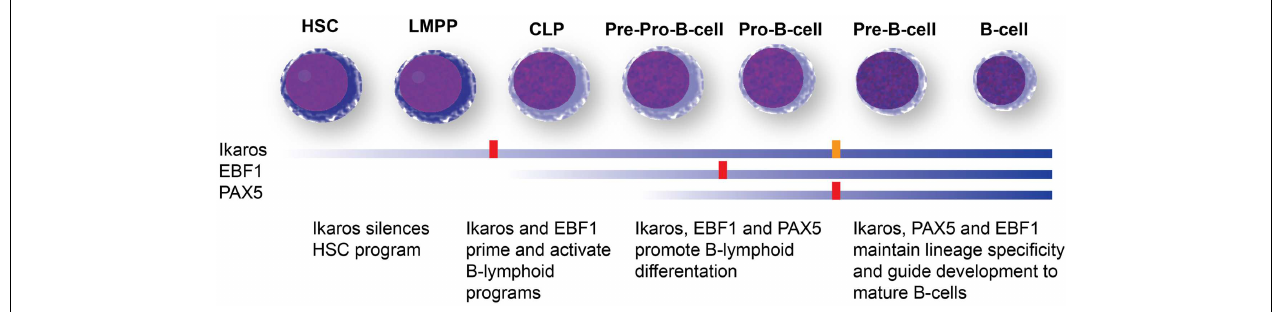
Pro-B stage (orange block). EBF1 is turned on in common lymphoid progenitors (CLPs) and controls lineage specification to the B-cell lineage. Loss of EBF1 in murine models leads to a differentiation block at the Pro-B stage (red block). Pax5 is turned on the latest and maintains lineage commitment. Loss of Pax5 causes a differentiation block at the Pro-B-cell stage. Neither Pax5 nor EBF1 appear to have a role in silencing hematopoietic stem-cell programs, which may explain why IKZF1 mutations are associated with a poor prognosis, while PAX5 and EBF1 mutations do not predict adverse outcomes. HSC: hematopoietic stem cells; LMPP: lymphoid-primed multipotent progenitors; CLP: common lymphoid